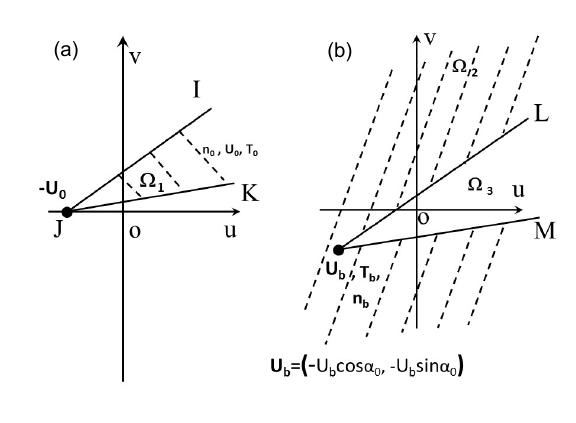
Figure 2. Velocity phases. ( a ) Jet; ( b ) Background flow. (cid:54) KJu = (cid:54) MU b u = θ 1 , (cid:54) IJu = (cid:54) LU b u = θ 2